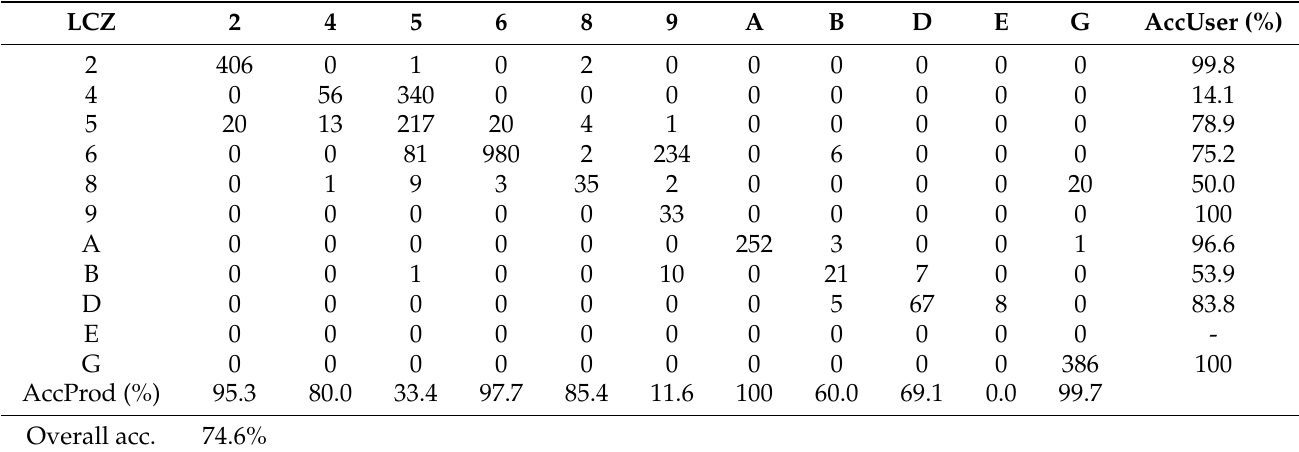
Table 4. Confusion Matrix of WUDAPT L0 vs.